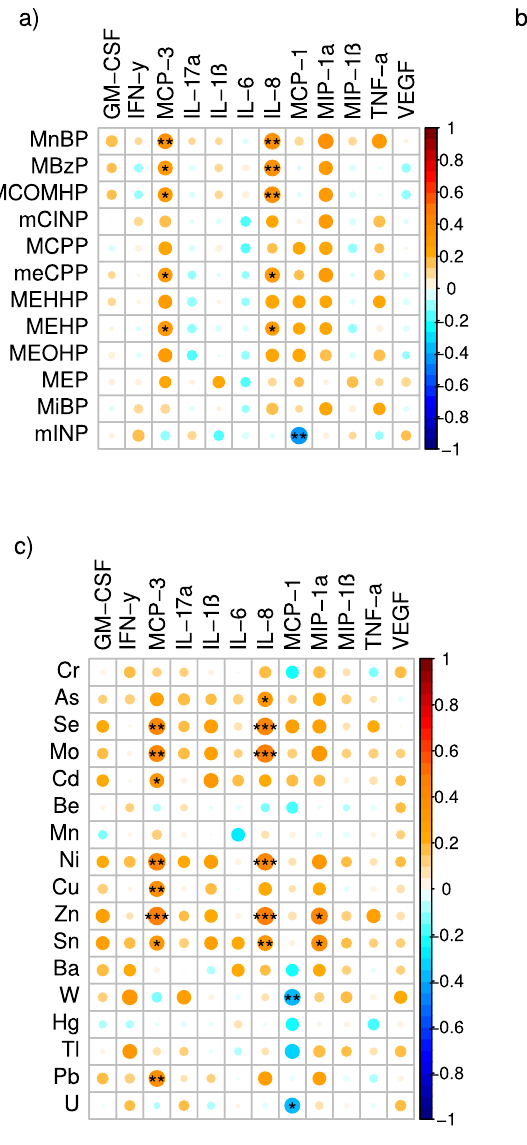
Figure 1. Spearman correlations between early pregnancy EDC exposures and first trimester inflammatory cytokines. Using the color spectrum, the orange color indicates a positive correlation, while the blue color indicates a negative correlation for cytokines with ( a ) phthalates, ( b ) phenols, and ( c ) metals. Circle size reflects the size of the correlation, with larger circles having correlations closer to 1 or − 1. Shade of orange or blue also reflects the strength of the correlation coefficient. Significance is noted as follows: ••• p < 0.01, •• p < 0.05, • p <